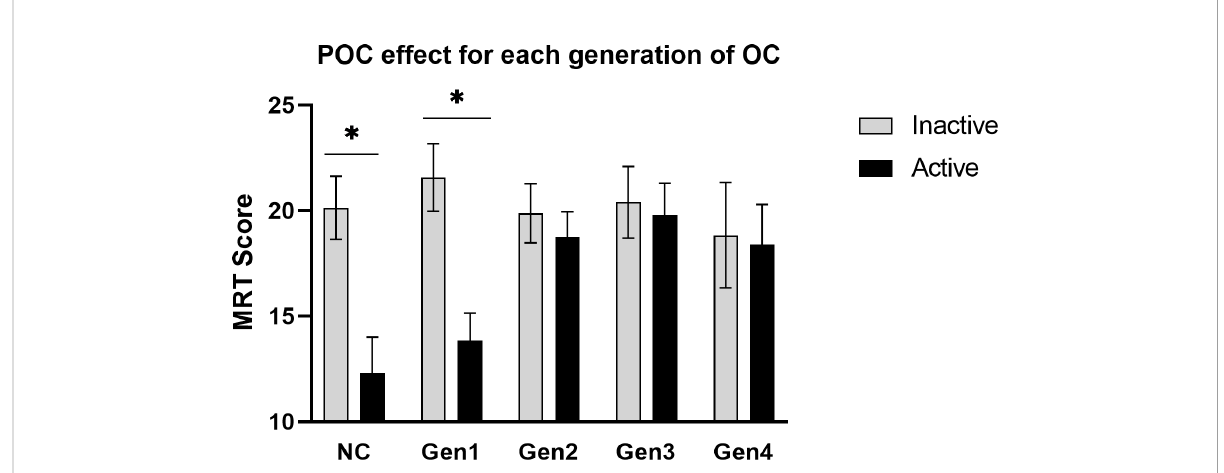
FIGURE 3 The POC effect for each pharmacological family of progestins. A robust phase-of-cycle (POC) effect was seen among users of early generation OCs (Gen1, n = 55) and naturally-cycling women (NC, n = 44), but to a lesser extent or not at all among the more recent families of progestins (Gen2, n = 74; Gen3, n = 44; Gen 4, n = 22). * p < .01.